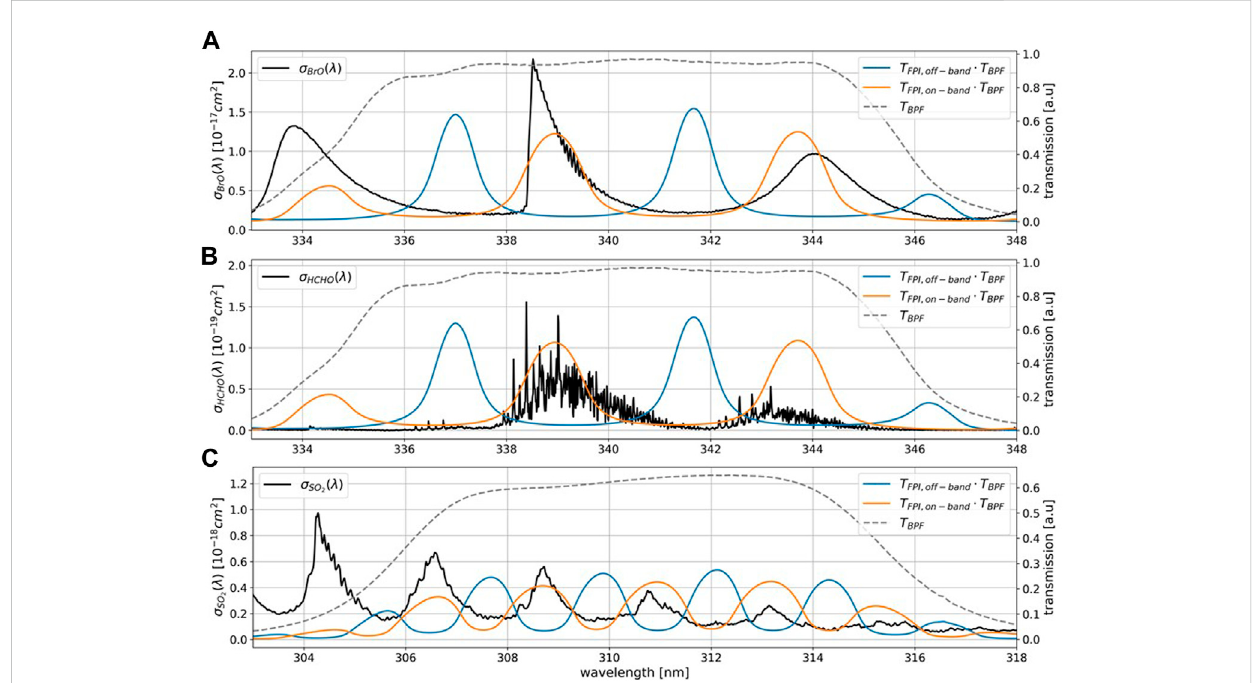
FIGURE 1 Trace gas detection principle of the IFPICS technique for BrO (A) , HCHO (B) and SO 2 (C) . The absorption cross sections σ BrO , σ HCHO , and σ SO2 of the tracegasesaremarkedinblack.Thedashedlinecorrespondstothetransmissioncurveofthebroadbandbandpass fi lterT BPF withacentralwavelengthof 340 nm for BrO and HCHO and 310 nm for SO 2 . The colored lines correspond to the FPI transmission spectrum T FPI multiplied with the bandpass fi lter transmission in on-band position A (orange) and off-band position B (blue).